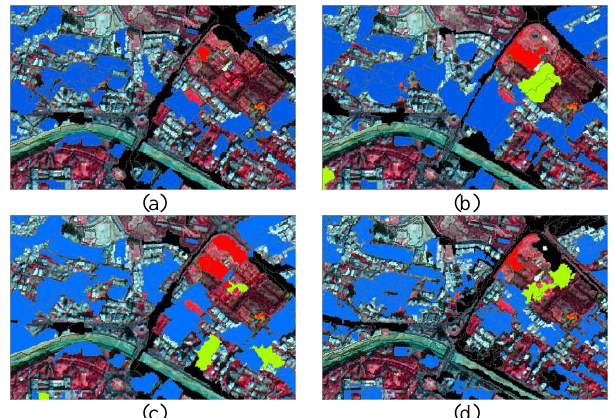
Figure 7. Edited training samples with KNN algorithm (k=20 and k'=3). (a), (b), (c), (d) show training data for segmentation